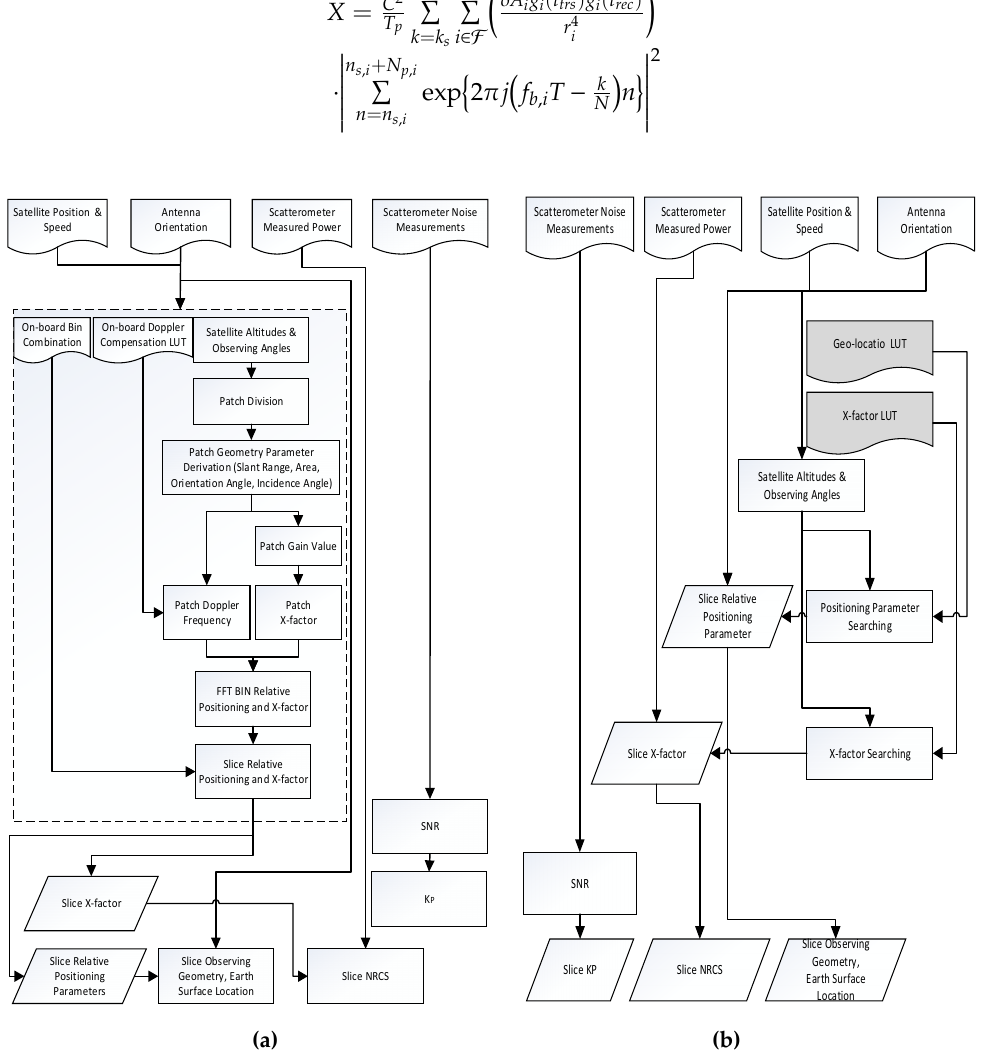
Figure 3. Traditional pre-processing routine ( a ) and on-board procedures with newly included look- tables (LUTs) ( b up tables (LUTs) ( b ).